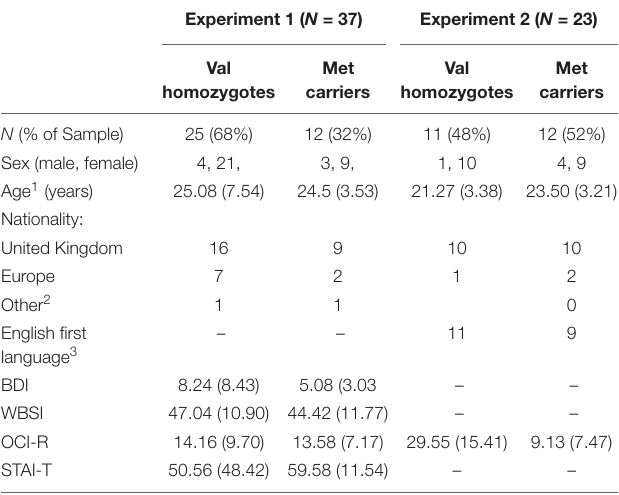
TABLE 1 | Subject demographics as a function of each experiment and BDNF Val66Met genotype